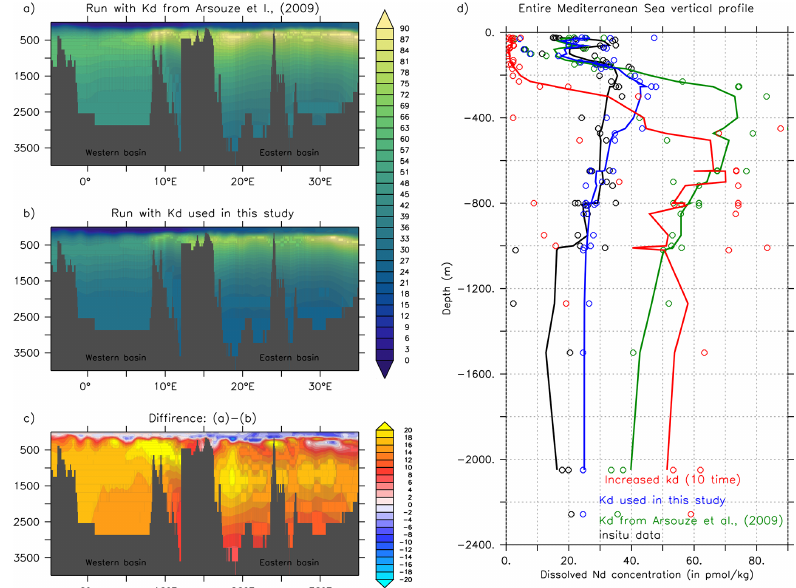
Figure A1. Left panel is the E–W vertical section of [Nd] (in pmolkg − 1 ) in the entire Mediterranean Sea using the kd value from (Arsouze et al., 2008) (a) , using the kd value from this study (b) and the difference between the two (c) . Right panel is the comparison of average vertical profiles of [Nd] (in pmolkg − 1 ) in the whole Mediterranean Sea from the two experiments (the experiment of kd value from (Arsouze et al., 2008) in green, the experiment using kd value from this study in blue and the experience with increased Kd in red) against in situ data (black line) from Tachikawa et al. (2004); Vance et al. (2004); Henry et al. (1994); Dubois-Dauphin et al. (2017); Garcia-Solsona and Jeandel (2020); Montagna et al. (2022).